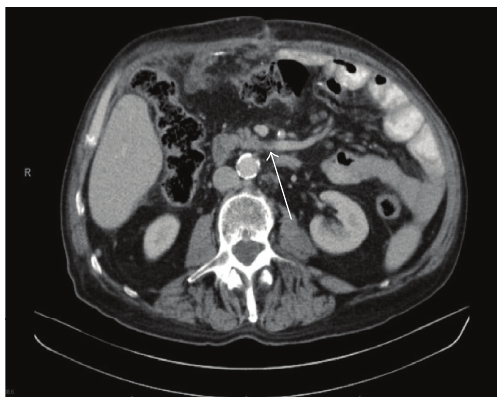
Figure 1: Posterior coursing first jejunal branch. Figure 2: Anterior coursing first jejunal branch.